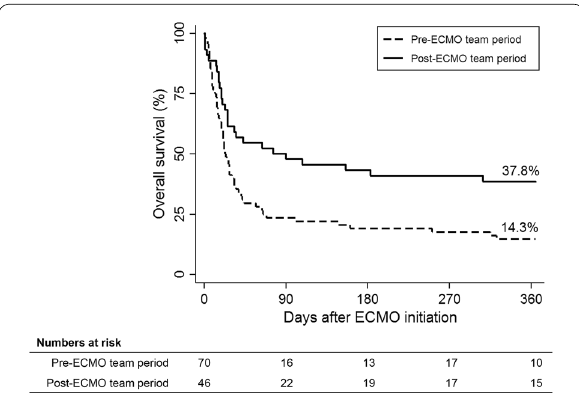
Fig. 2 Overall survival at the 1-year follow-up. Cumulative survival 1 year after ECMO initiation according to the presence of an extracor- poreal membrane oxygenation (ECMO)